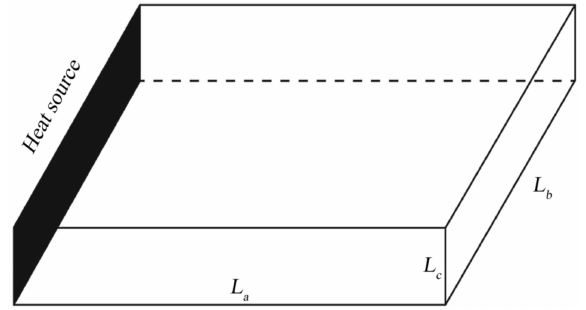
Figure 1. Schematic diagram of the tested material.